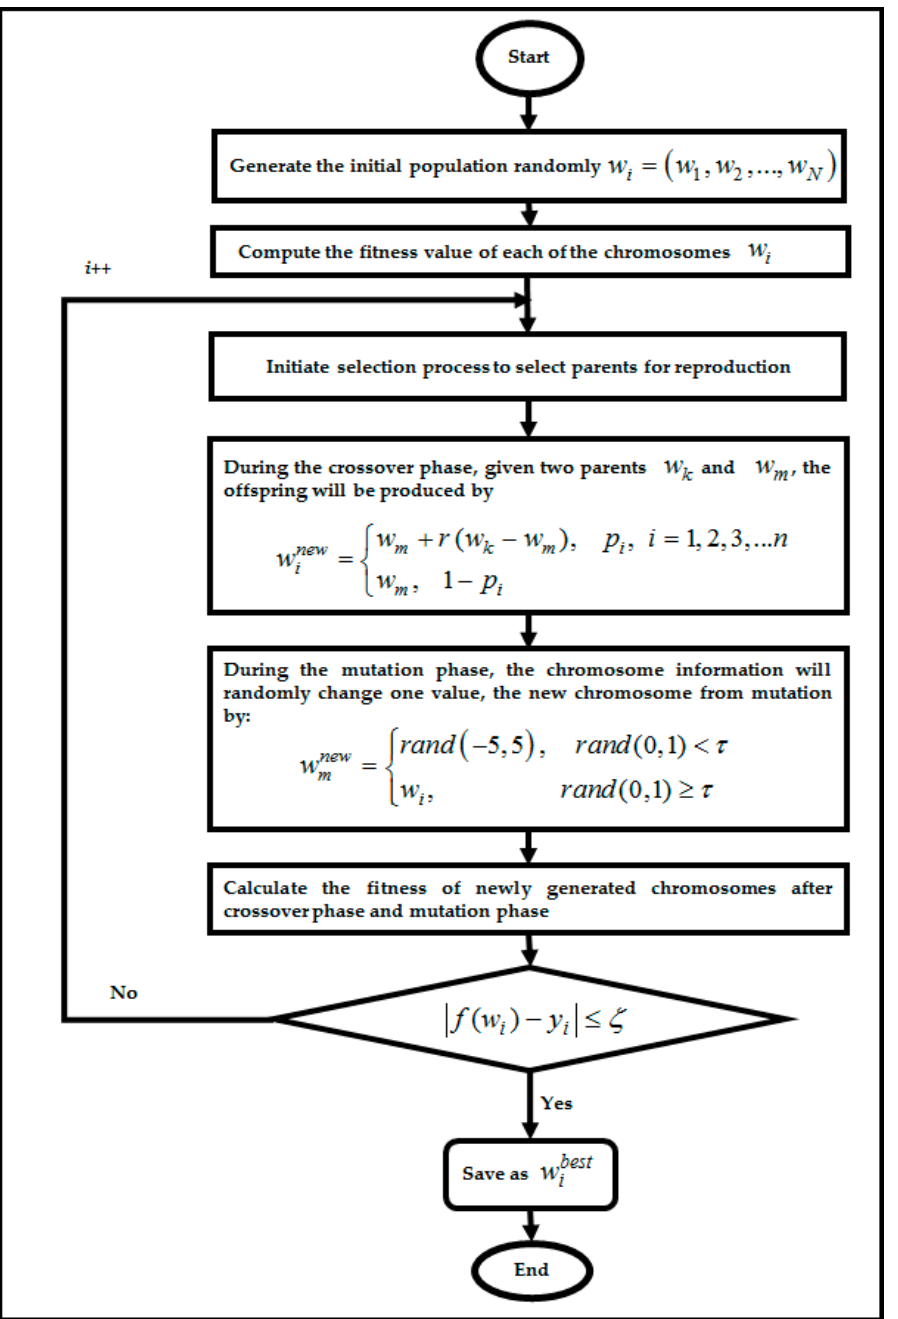
Figure 3. The implementation of genetic algorithm (GA) in radial basis function neural network-based 2-satisfiability reverse analysis (RBFNN-2SATRA).